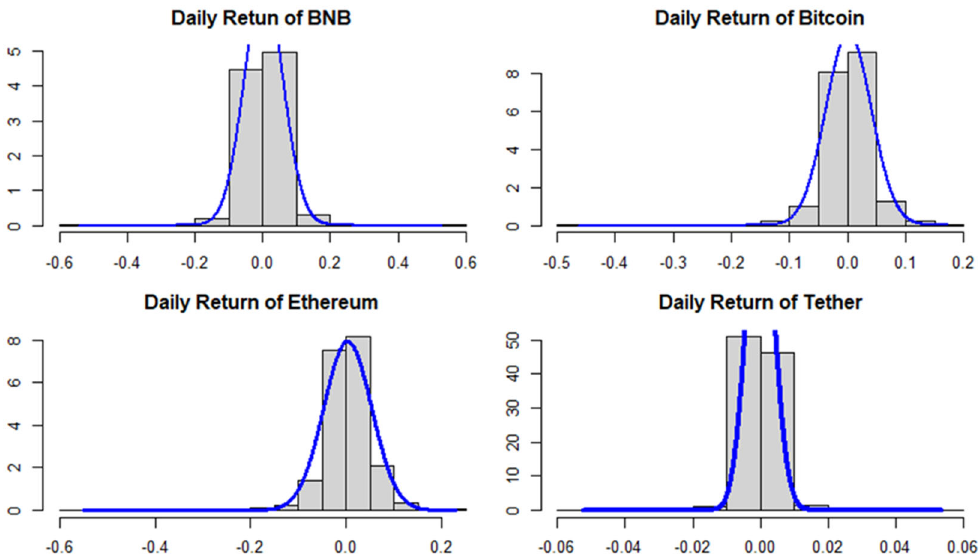
Figure 2. Histogram plot of cryptocurrency returns.